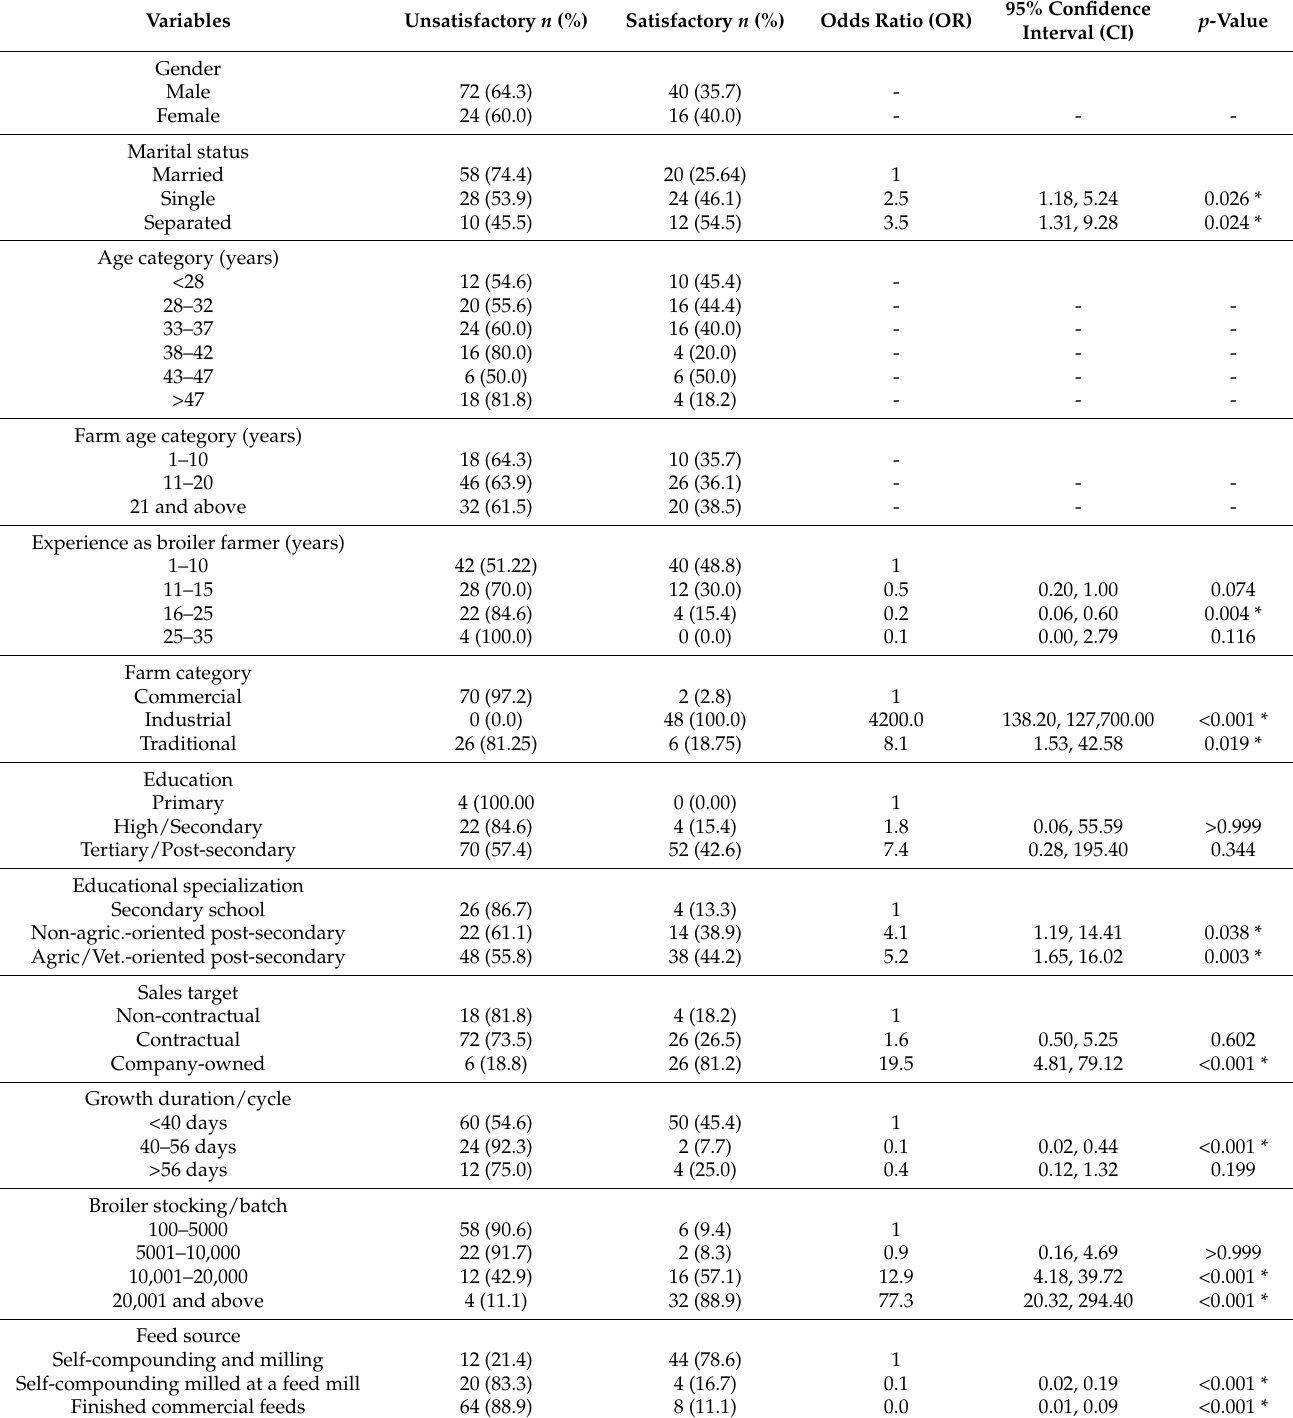
Table 9. Factors influencing risk perception to antimicrobial use and resistance among broiler grow- out farmers in Oyo State,